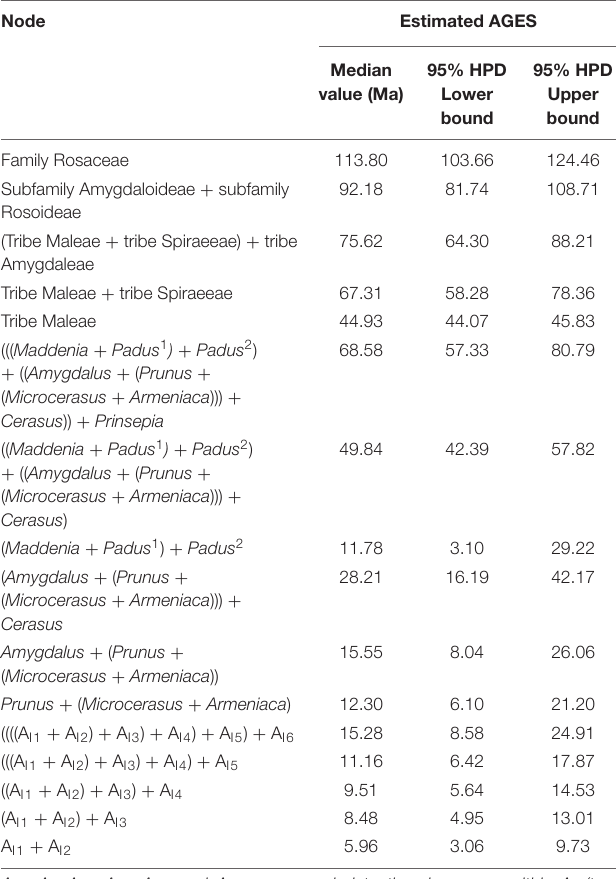
TABLE 4 | Estimated divergence times of major clades across Rosaceae using Bayesian method.